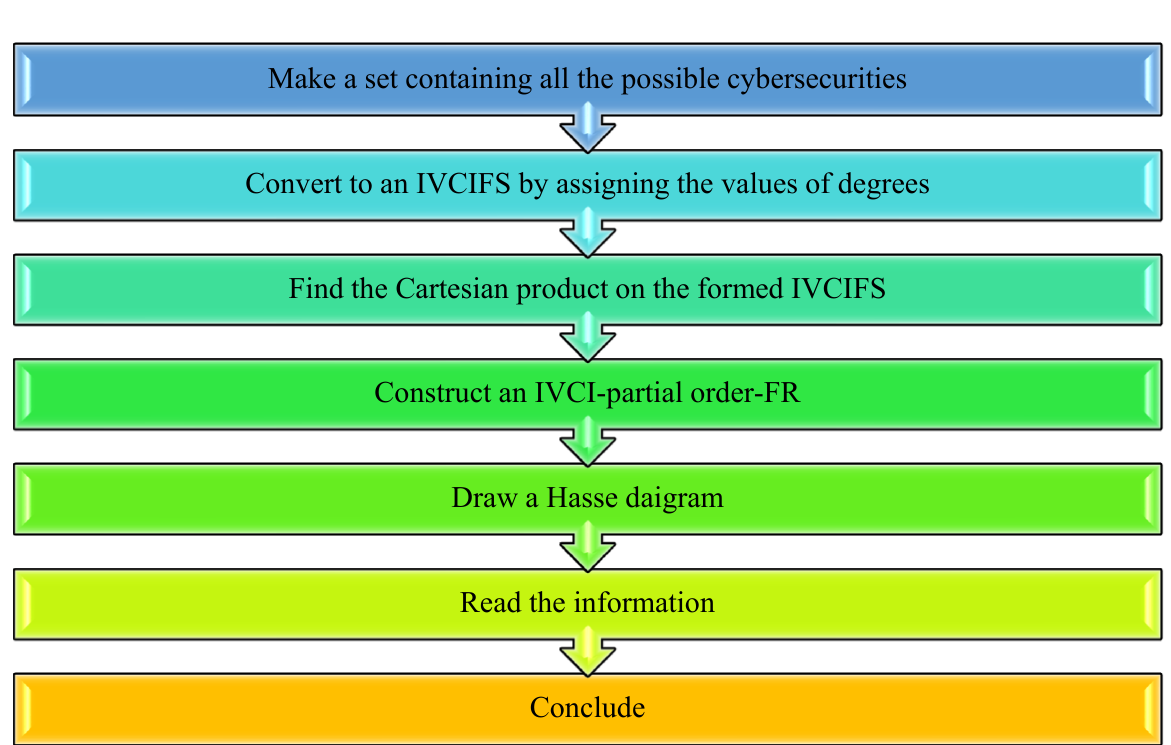
Figure 5. Flowchart of the process for selecting the best cyber-security.